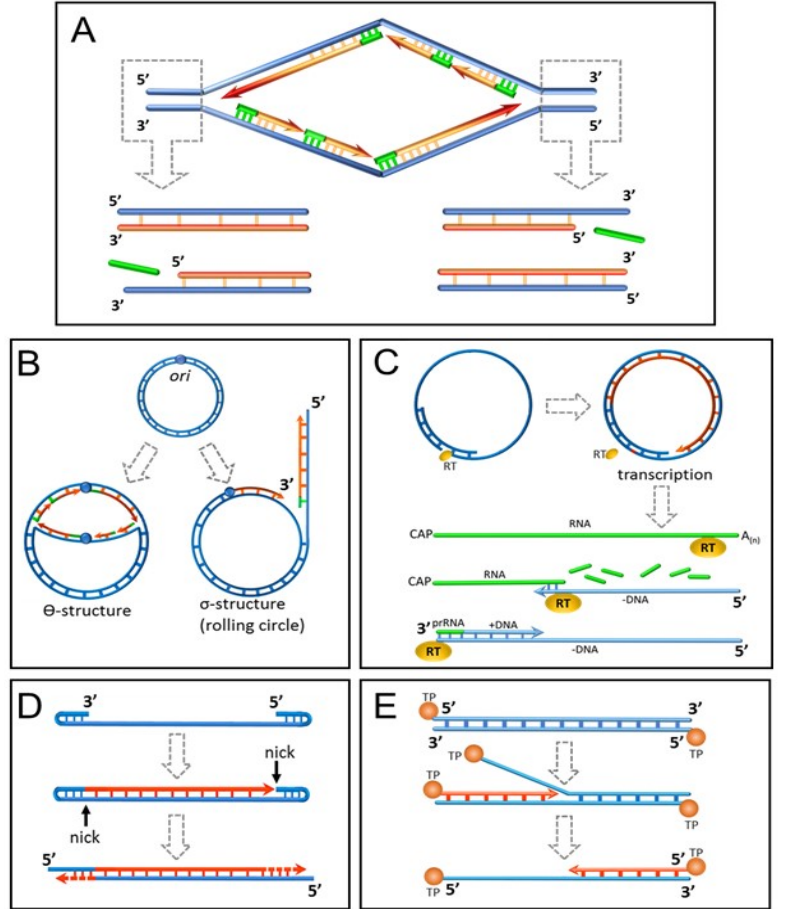
Figure 1. The problem of incomplete DNA replication and its solution by “primitive” organisms. ( A ) Incomplete replication of the 3’ end of DNA in eukaryotic cells. Replicons located in the telomere region cannot displace the last RNA primer of the lagging strand. ( B ) A covalently closed circular genome replication. In theta replication (prokaryotes, viruses), the last RNA primer of the lagging strand is replaced by the leading strand. A rolling cycle mechanism (viruses, plasmids) uses a single-stranded nick as a primer for DNA synthesis. As a result, a concatemer containing several complete genome copies is formed. ( C ) Hepadnaviruses do not have a covalently closed circular genome, but it can be easily restored by reparative DNA synthesis after cell infection. Despite this, the virus uses reverse transcription as a strategy for its genome replication. Whole genome RNA, after its translation, is used as a template for minus DNA strand synthesis. Reverse transcriptase (RT) includes a domain that can prime DNA synthesis from a tyrosine residue. The incomplete plus DNA strand is synthesized by DNA polymerase primed with the rest of the degraded whole genome RNA. ( D ) Parvoviruses use hairpins at the ends of their DNA (rabbit ears) as primers for DNA polymerase. ( E ) Adenovirus DNA polymerase forms a complex with a terminal protein (TP) that can act as a primer for unidirectional DNA replication.